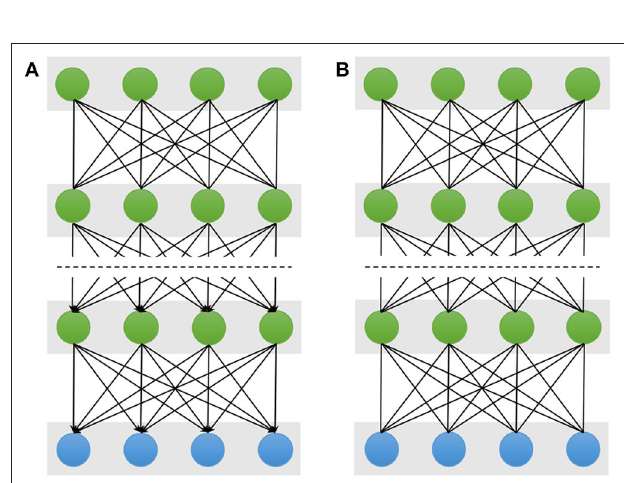
FIGURE 3 | Schematic illustration of Deep Belief Networks (A) and Deep Boltzmann Machine (B) . The double-headed arrow represents the undirected connection between the two neighboring layers, and the single-headed arrow is the directed connection. The top two layers of the DBN form an undirected generative model and the remaining layers form directed generative model. But all layers of the DBM are undirected generative